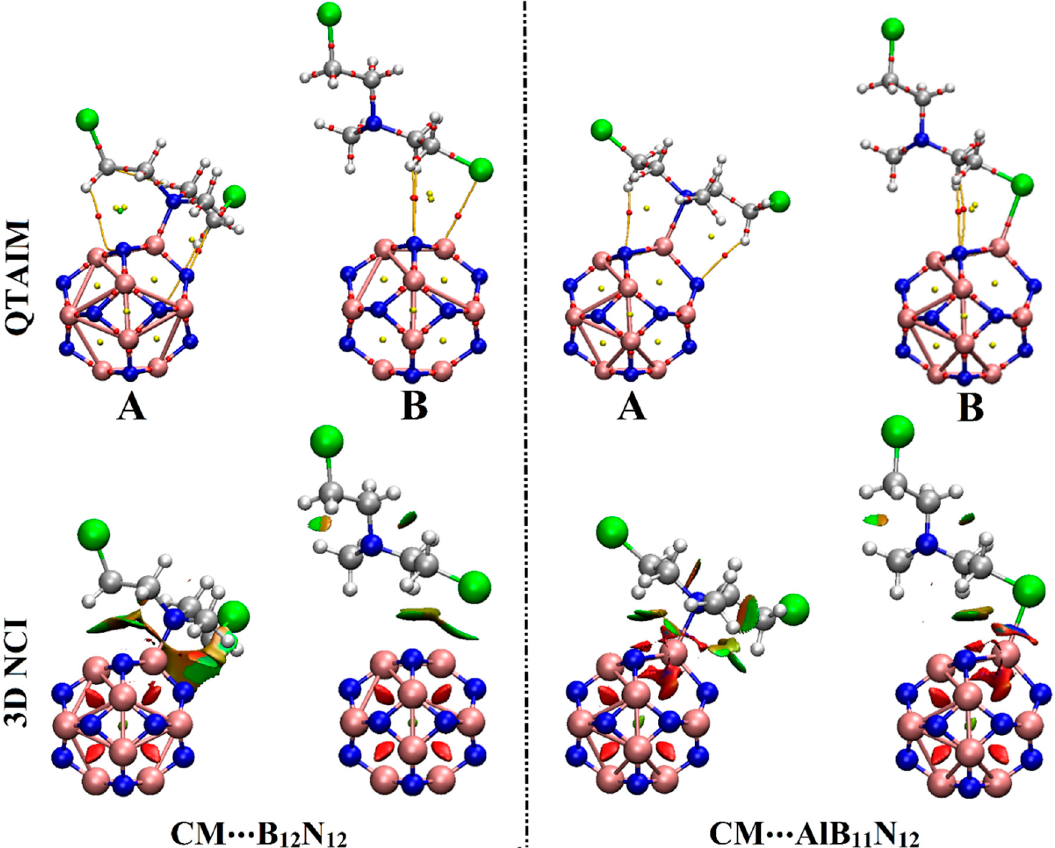
Figure 5. Visualized QTAIM and 3D NCI diagrams of the optimized CM ∙∙∙ B 12 N 12 and ∙∙∙ AlB 11 N 12 complexes in configurations A and B. In QTAIM diagrams, red dots represent the location of BCPs and BPs. Three-dimensional NCI isosurfaces are graphed with a reduced density gradient value of 0.50 au and colored from blue to red according to sign ( λ 2 ) ρ ranging from − rangi (blue) to 0.020 (red) au.